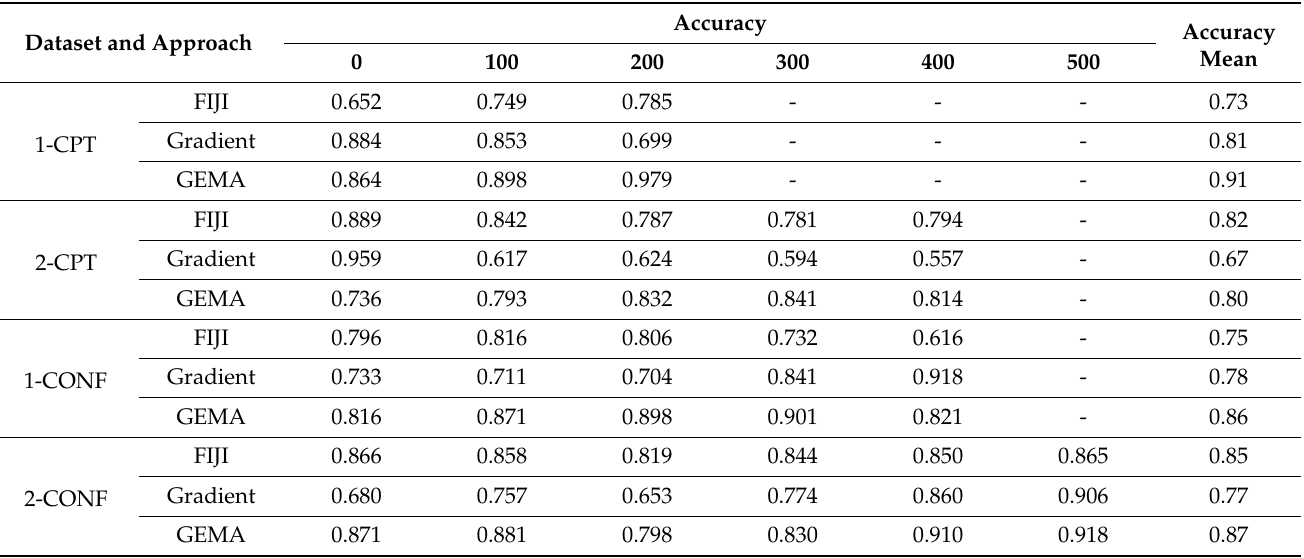
Table 1. Accuracy computed through the confusion matrix by Gradient, FIJI and GEMA approaches relative to Gold-standard